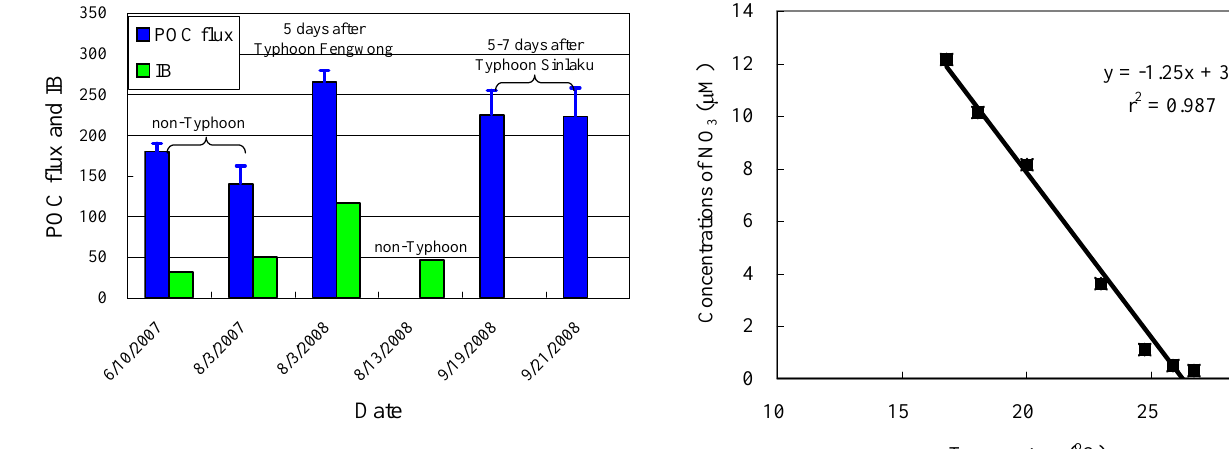
Fig. 5. POC export fluxes (blue bars, mgCm − 2 d − 1 ) and integrated chl- a (IB, green bars: mgm − 2 ) in the study region on 6/10 in 2007, 8/3 in 2007, and 8/13 in 2008 (non-typhoon conditions), and during typhoon events in 2008 on 8/3 (typhoon Fengwong), and 9/19 and 9/21 in 2008 (typhoon Sinlaku).